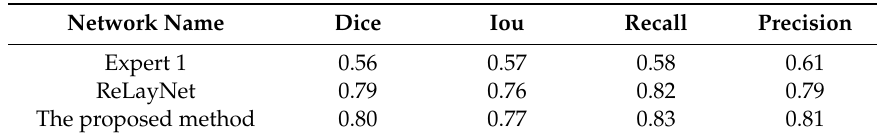
Table 7. Quantitative comparison of segmentation results around fovea edema regions for the expert 2 annotations as the ground